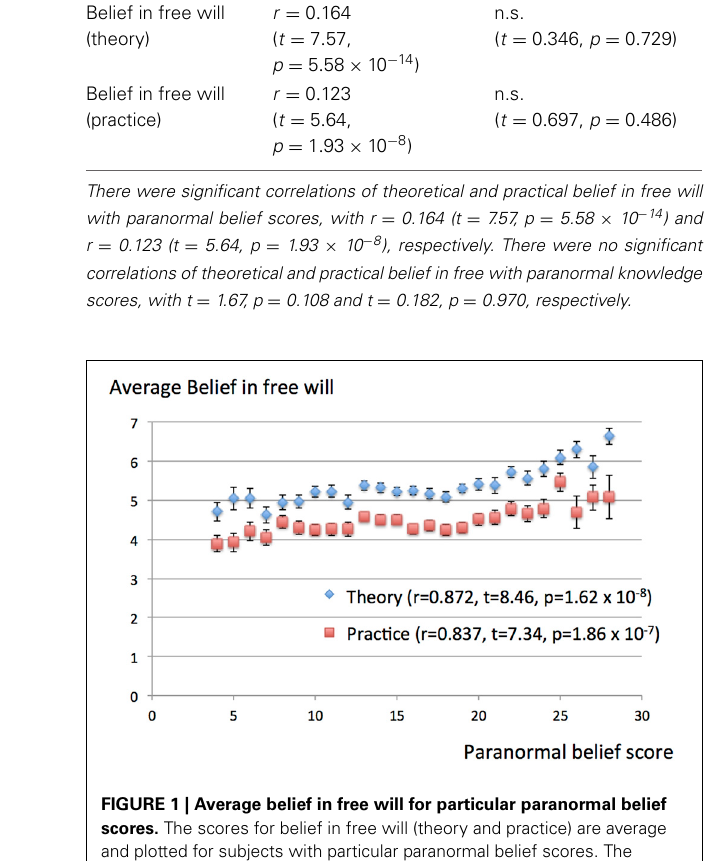
Table 2 . The graph plotting the average free will belief scores for subjects with particular paranormal belief scores reveal a monotonously increasing relationship ( Figure 1 ), with correla- tion coefficients between the paranormal belief scores and beliefs